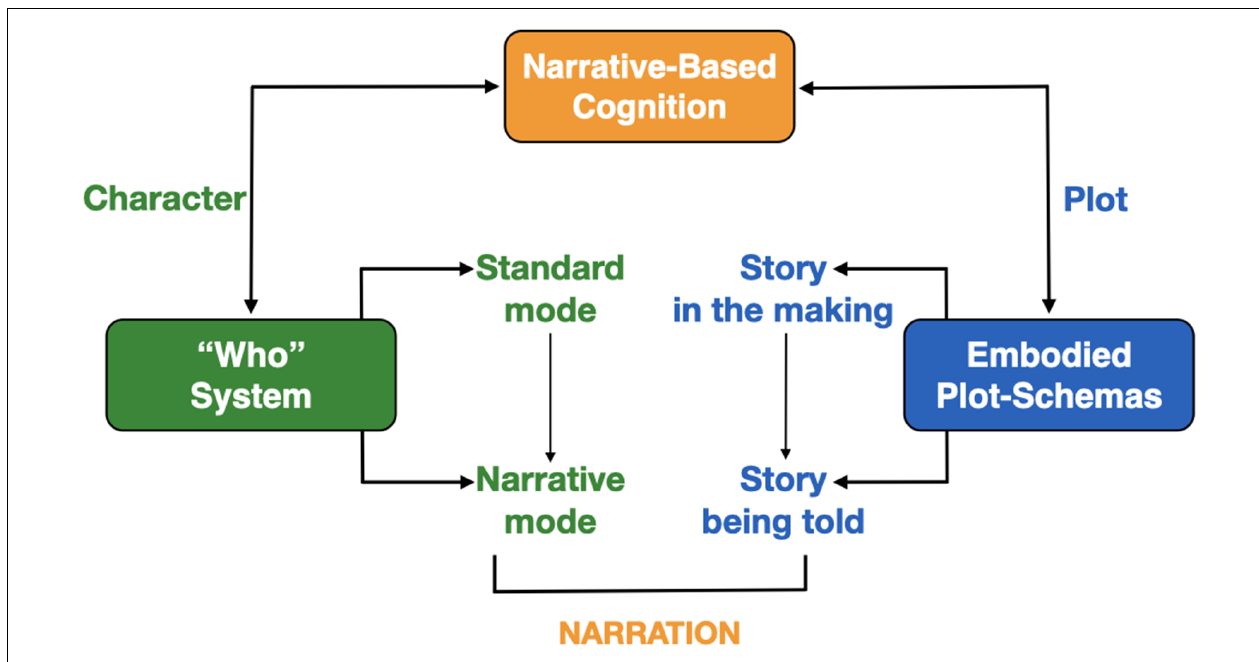
FIGURE 7 | The integration of character and plot in human cognition. The figure integrates information from Figure 4 about the standard and narrative modes of cognition with information from Figure 6 about embodied plot-schemas into a concept of NBC that unifies character and plot in human cognition.